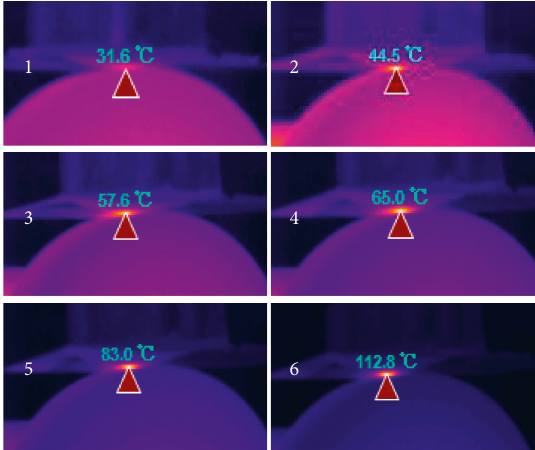
Figure 2: The temperature distribution at different speeds.